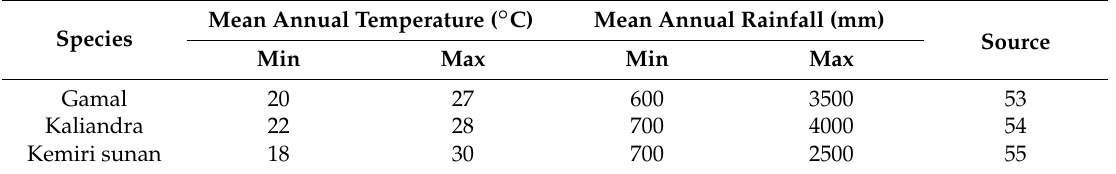
Table A1. Environmental requirements for four tested bioenergy